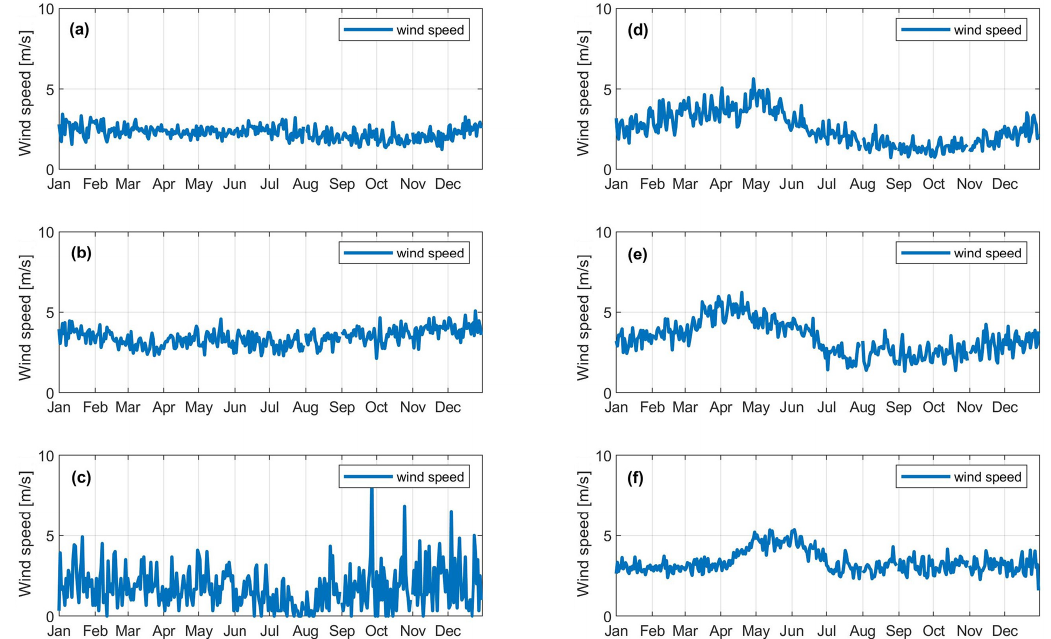
Figure 8. Nighttime (i.e., 18:00, 21:00, 00:00, 03:00LT) long-term mean (1980–2010; 30 years) of wind speed in six selected stations that are located in dew zone A–F. (a) Ramsar (dew zone A), (b) Zanjan (dew zone B), (c) Isfahan (dew zone C), (d) Tabas (dew zone D), (e) Ahvaz (dew zone E), and (f) Bandar Abbas (dew zone F). Data were obtained from the meteorological organization of Iran.